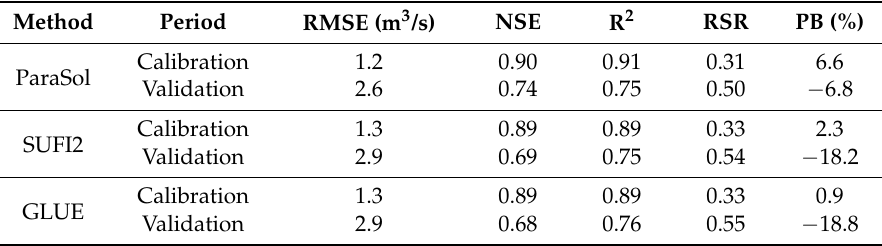
Figure 4. Scatterplots between the best simulation and the observation with the 95% confidence interval (the shaded area). Table 2. Evaluation of model performance in streamflow simulation during the 3-year (2008–2010) calibration and 2-year (2011–2012) validation periods.